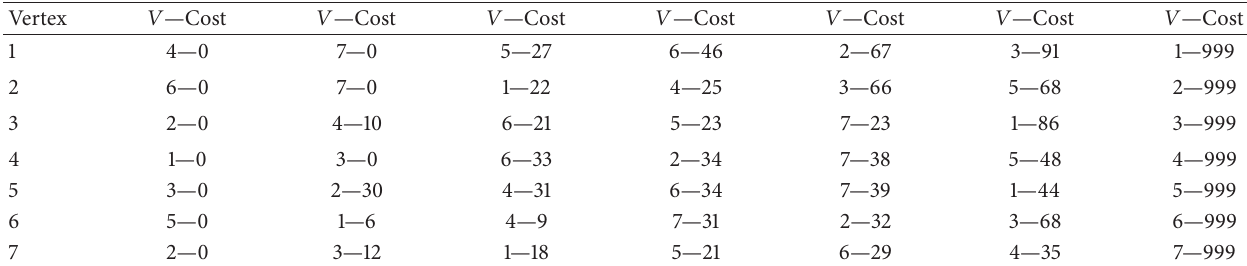
Table 3: The alphabet